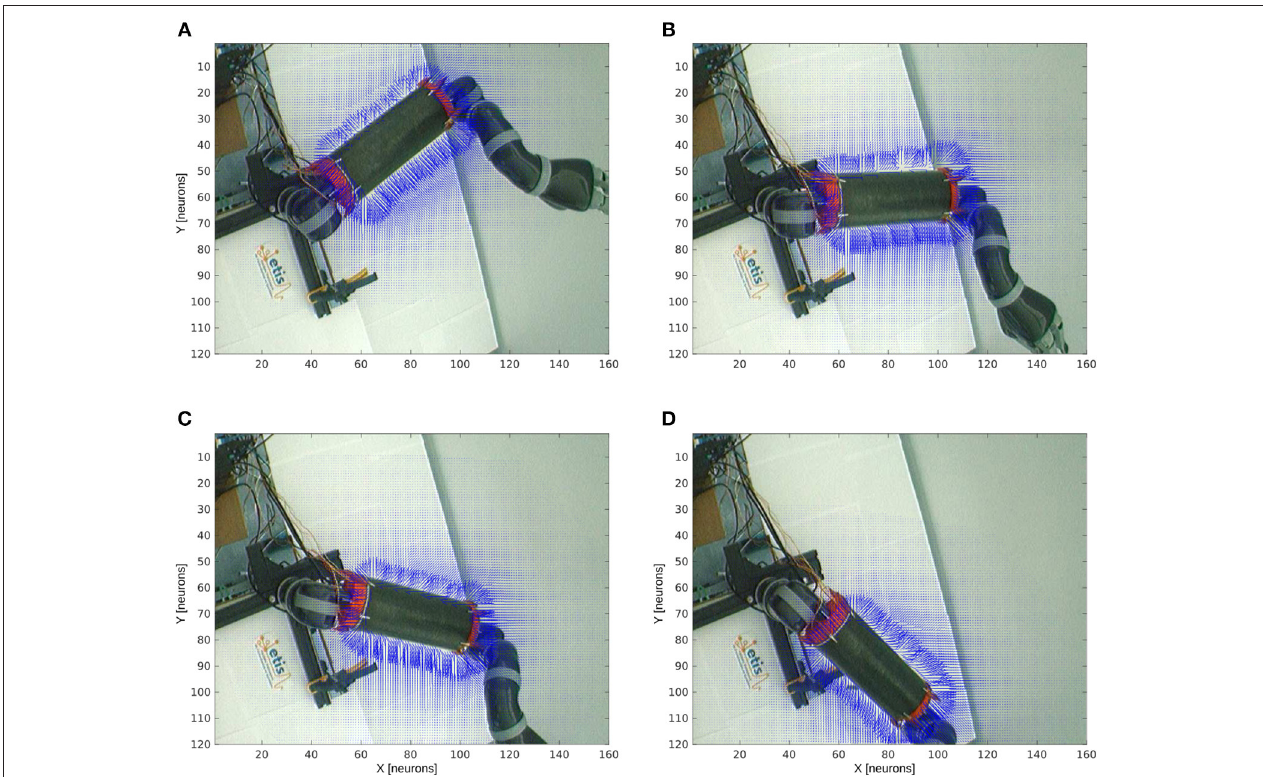
FIGURE 8 | Peripersonal space and arm-centered RF for various motor positions. We display in (A–D) the information about the compound GF receptive fields resulting from the interaction between the hand and target receptive fields, for all the target locations in the visual space and for the four motor angles 20 ◦ , 50 ◦ , 70 ◦ , and 100 ◦ respectively. Each vector indicates the orientation of the compound GF receptive field and their length indicates the proximity of the target to the robot arm. The direction of the arrows changes with respect to the motor angle and their length is non-linearly proportional to the distance to it.